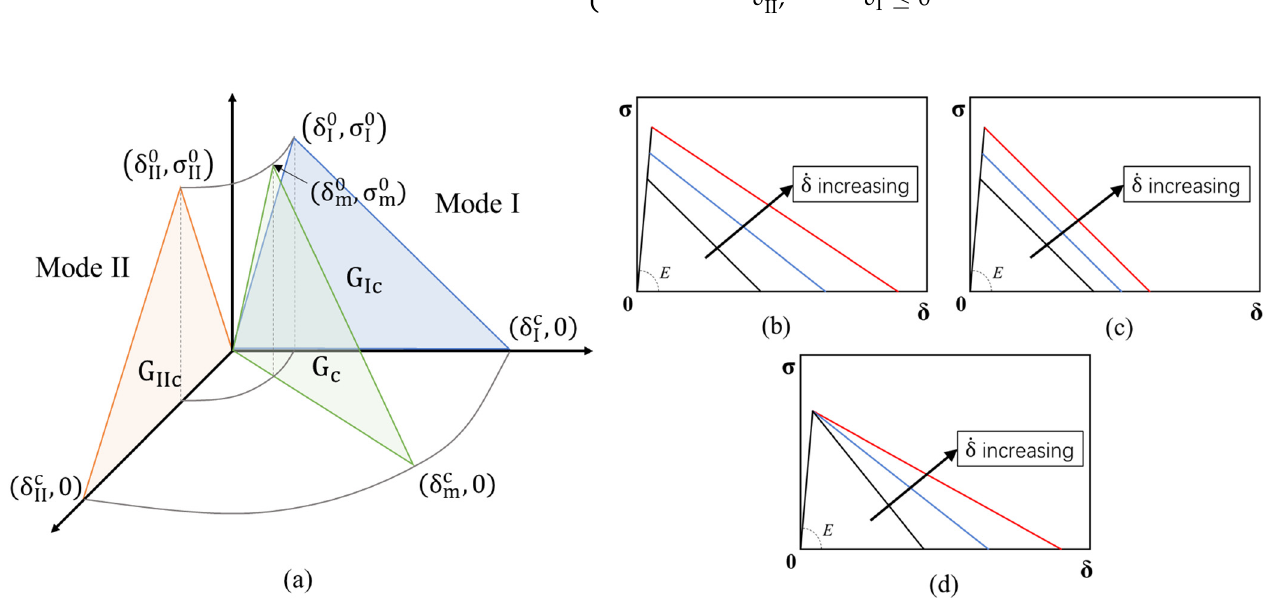
Figure 2. ( a ) Mixed-mode cohesive model and traction-separation law of pure mode I or II rate-dependent cohesive model: ( b ) logarithmic model ( c ) exponential model ( d ) power model.